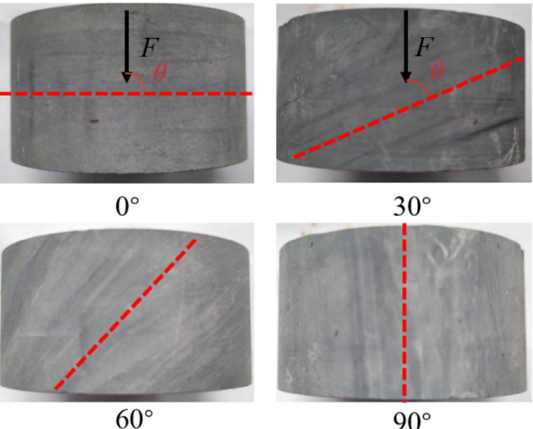
Figure 1. Schematic diagram of the direction of external dynamic load action and the angle of the sample layers .